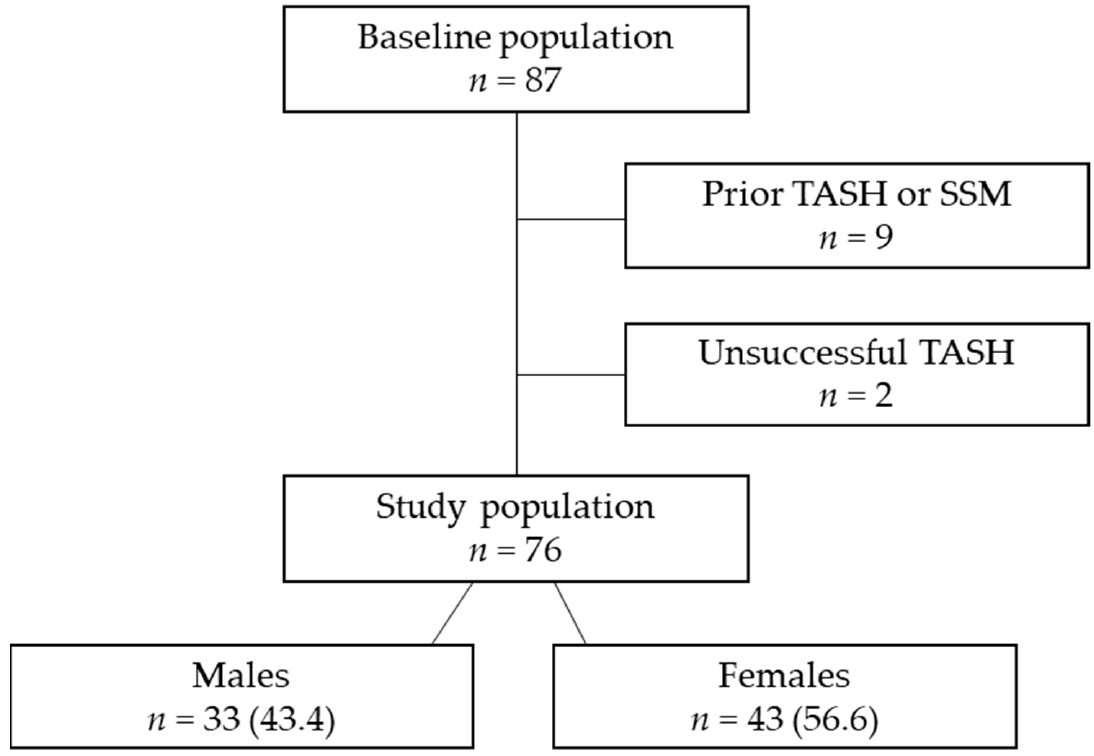
Figure 1. Derivation of the analytic cohort. TASH—transcoronary ablation of septal hypertrophy using alcohol; SSM—surgical septal myectomy. Data are presented as n (%).